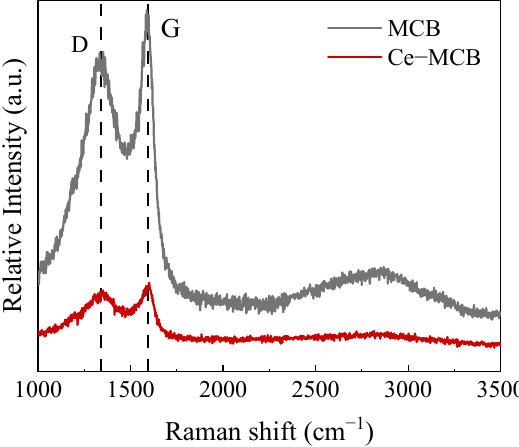
Figure 3. Raman spectra of MCB and Ce-MCB.